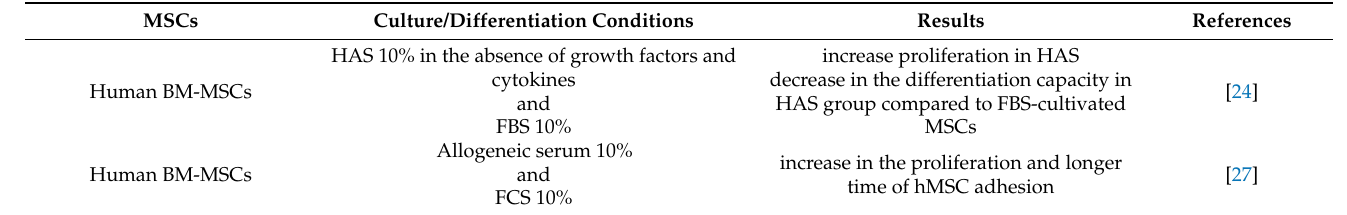
Table 1. Overview of the in vitro studies that summarize the effects of human serum in MSC cultures.